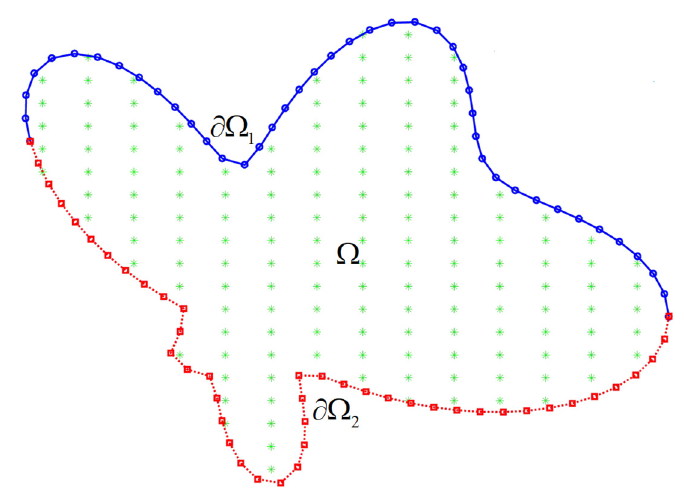
Figure 1. Schematic illustration for a computational domain.